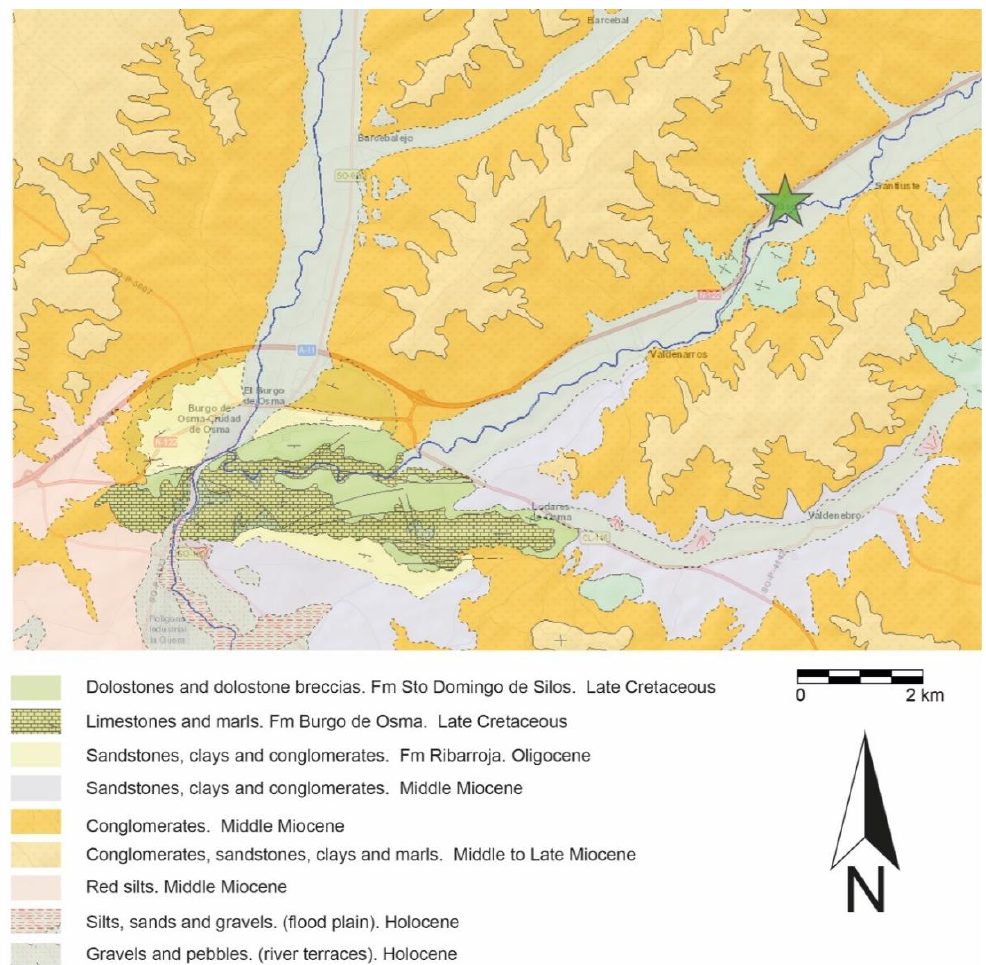
Figure 8. Geological map and location of the Arroyo de La Dehesa de Velasco site (star).